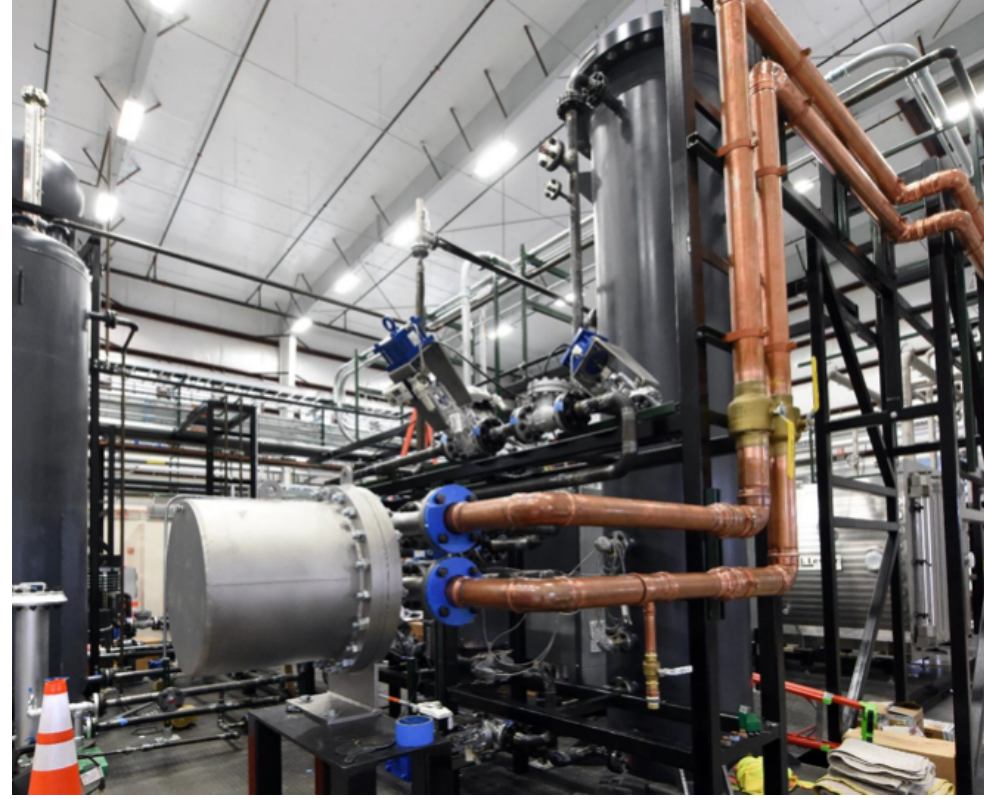
Figure 2. A picture of TEDS with a heat